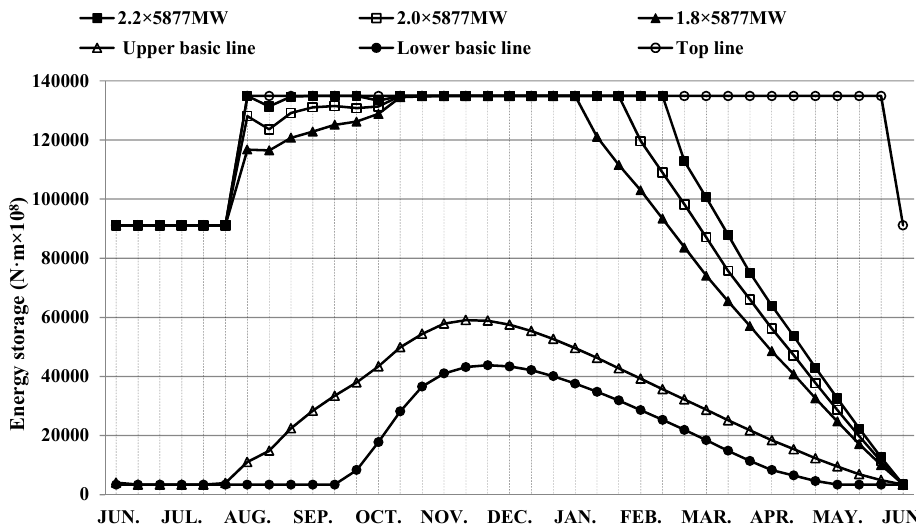
Figure 9. Optimal energy storage operation chart.